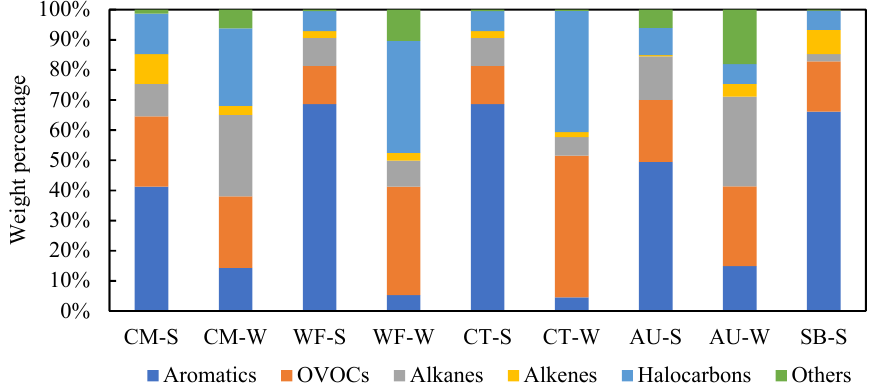
Figure 2. VOCs chemical compositions of nine industrial coating sub-sectors (note: CM: construc- tion machinery coating; WF: wood furniture coating; CT: container coating; AU: automobile coating; SB: shipbuilding coating; -S: solvent-based; -W: water-based).